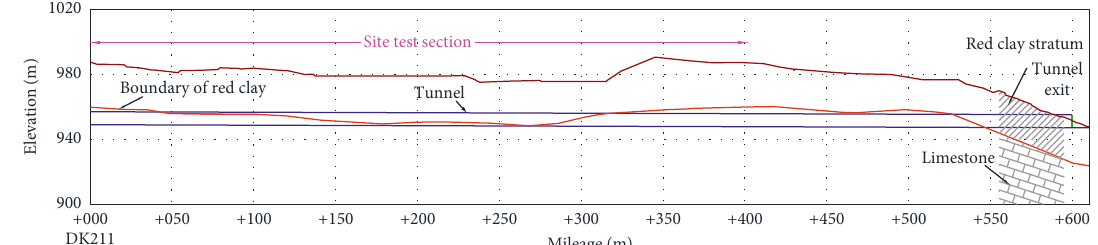
Figure 1: Longitudinal profile of shallowly buried section of Qinggangshan tunnel.